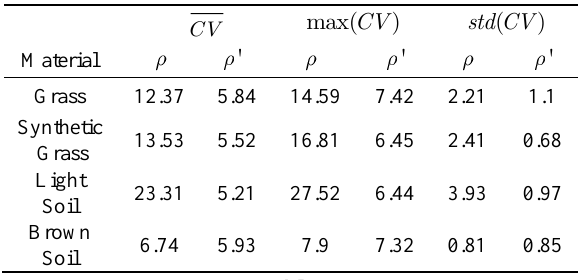
Statistic of CV parameters for different materials. ρ and ρ' are the measured and corrected reflectance measurements,